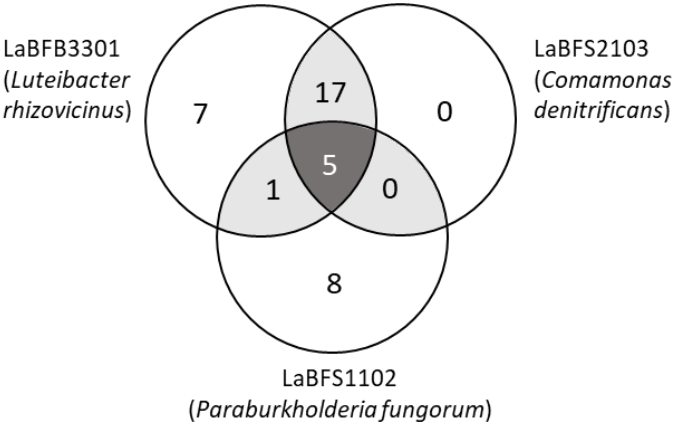
Figure 11. Venn diagram of shared and unique peaks of metabolites enriched and identified in the methanolic extract of the three strains LaBFB 3301, LaBFS1102 and LaBFS2103, using HPLC-Q-Exactive-Orbitrap ® . Table 2. List of metabolites detected in the methanolic extracts of the three strains LaBFB3301, LaBFS1102 and LaBFS2103, using UHPLC-Q-Exactive-Orbitrap, combined with the identification using the software, Compound Discoverer (Thermo).